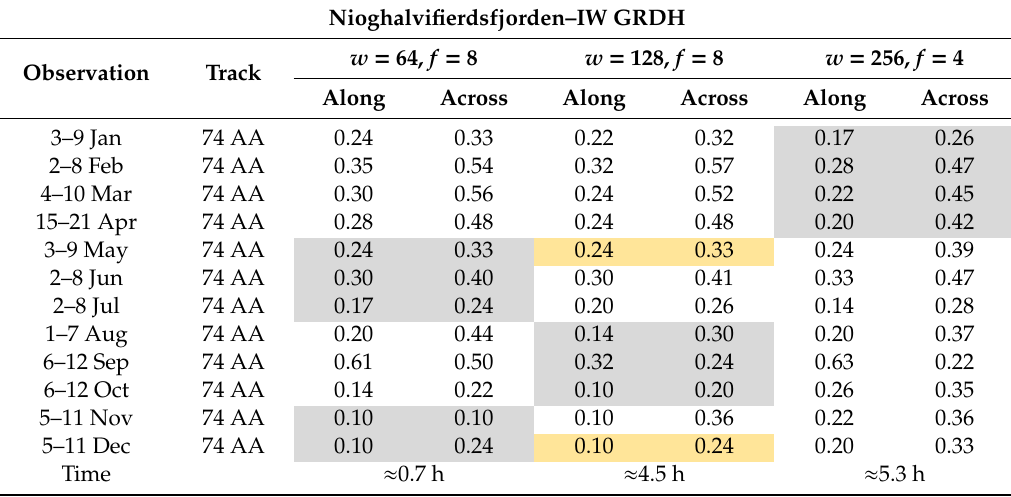
Table 7. NI, IW GRDH product class experiments, RMSE (expressed in m / day) with respect to available literature data measured along selected along / across flow